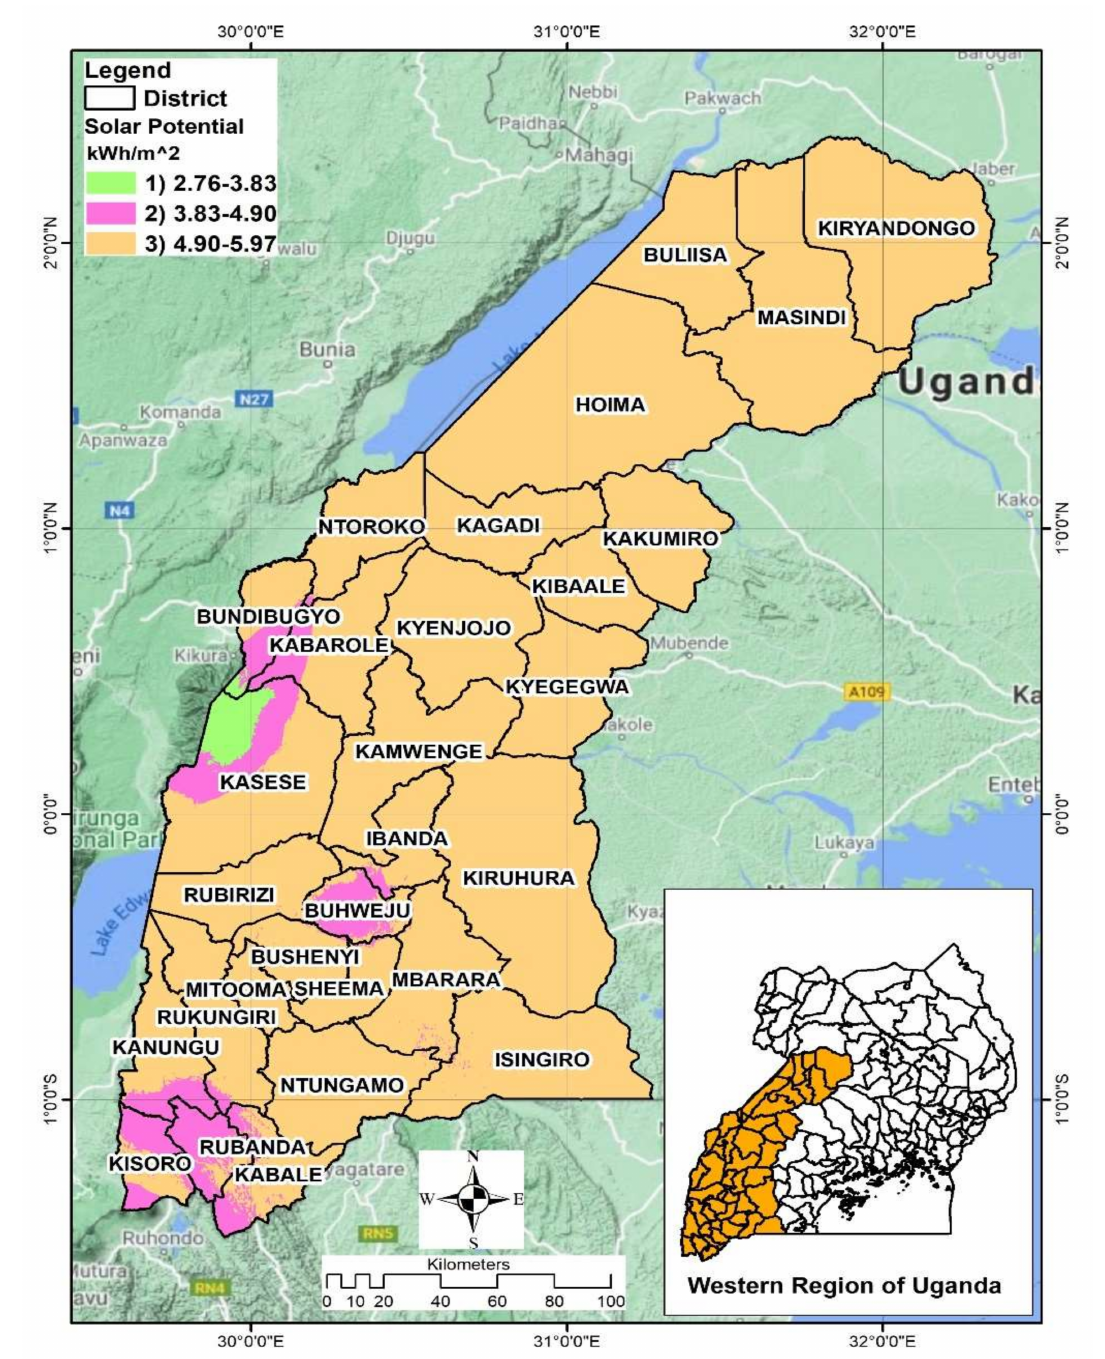
Figure 13. Map showing solar potential in the study